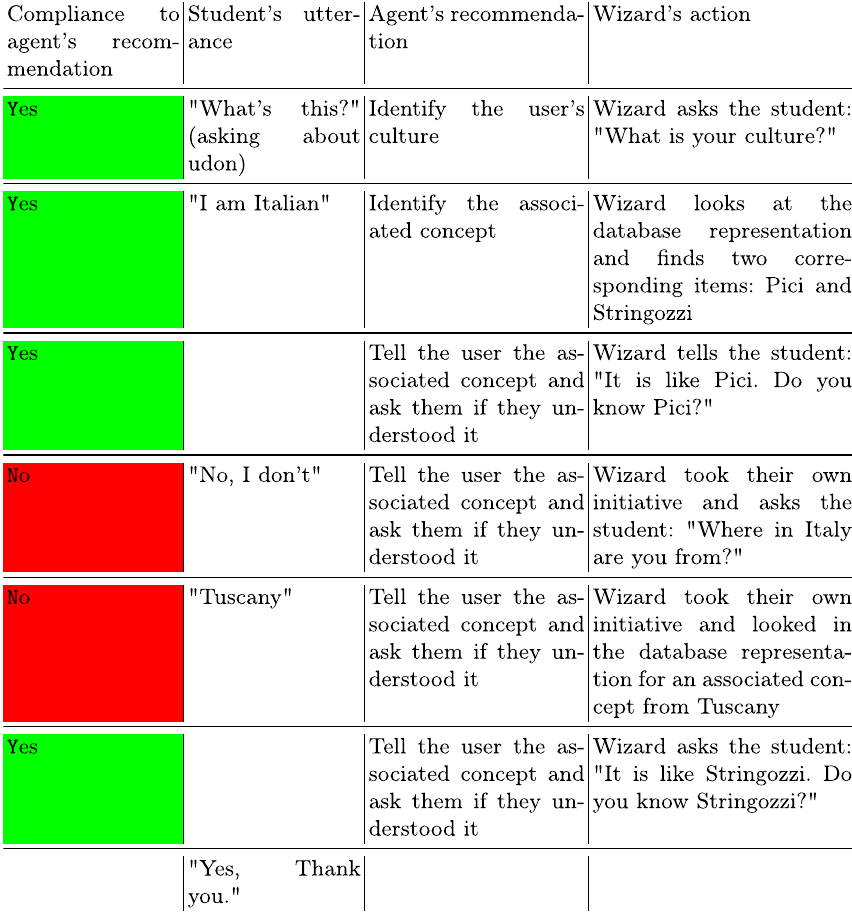
Table 3 Dialogue between the wizard and the novice agent and wizard’s compliance to recommendations